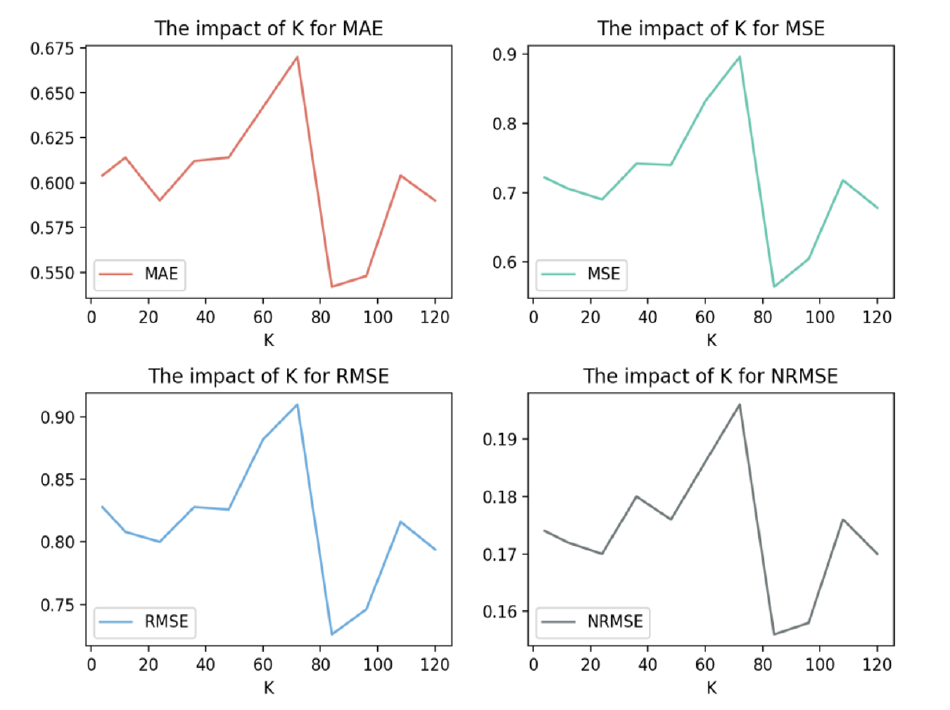
Figure 9. Impact of parameter K on four error measurement indexes on the predicted value of dissolved